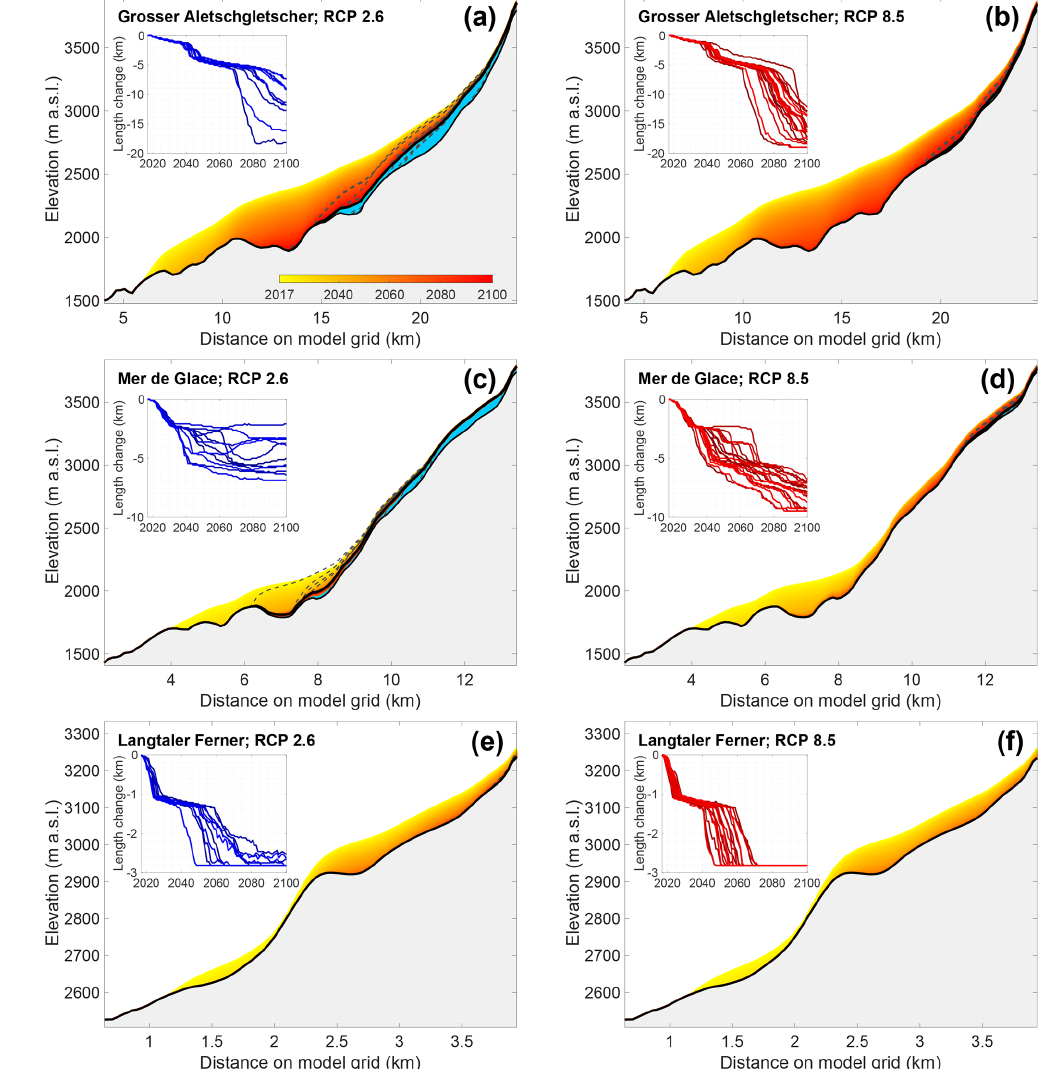
Figure 11. Future evolution of the Grosser Aletschgletscher (a, b) , Mer de Glace (c, d) and Langtaler Ferner (e, f) under RCP2.6 (a, c, e) and RCP8.5 (b, d, f) . The 2017–2100 evolution corresponds to the multi-model mean surface evolution, while the blue area is the multi-model mean glacier geometry at the end of the century. The dotted lines represent the 2100 glacier geometries for individual RCM simulations (see Table S1). The insets represent length changes over the 2017–2100 time period for every individual RCM